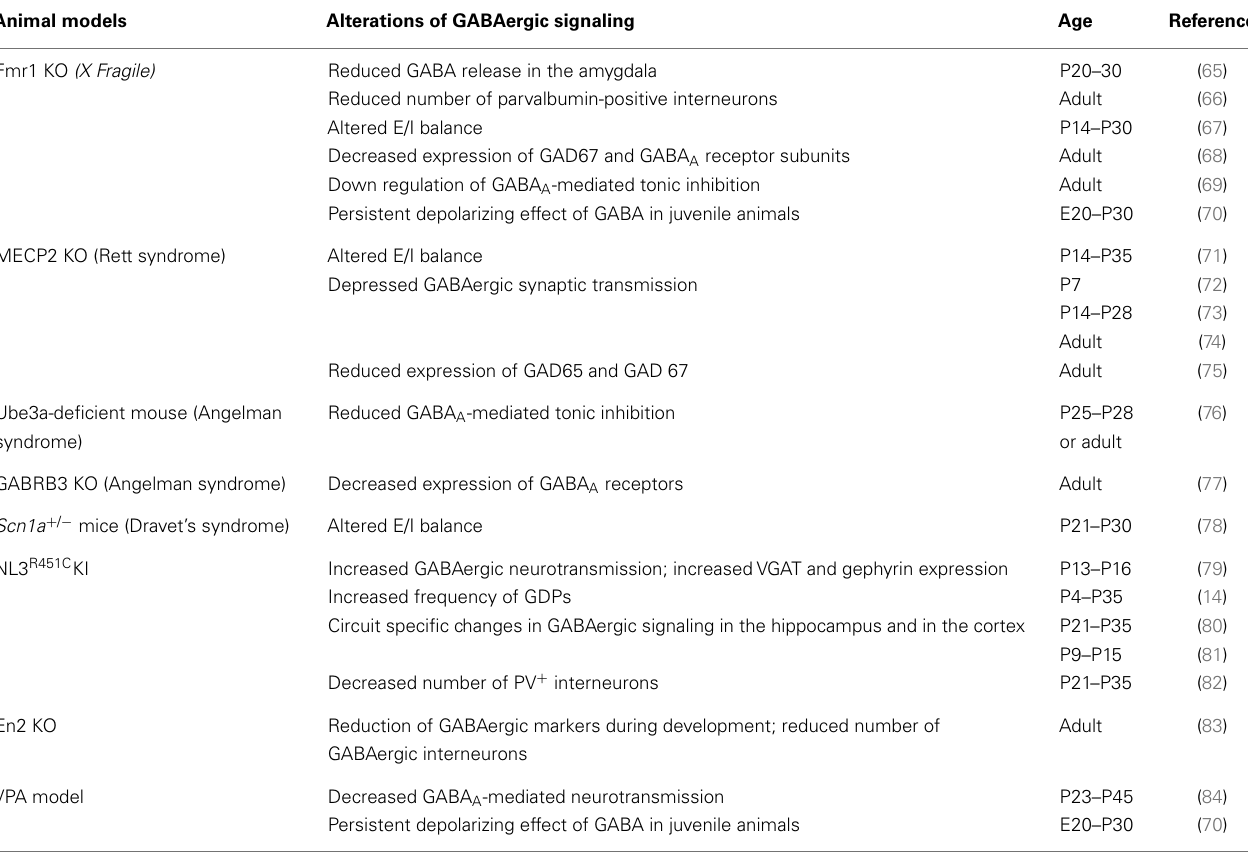
Table 2 |Alterations of GABAergic signaling in animal models ofASDs (E, embryonic day; P, postnatal day) . Animal